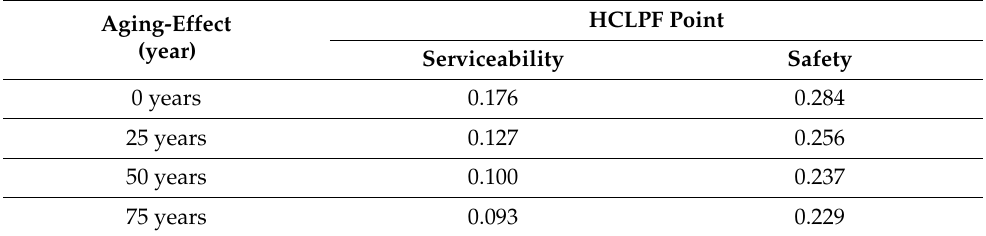
Figure 19. Reliability index curve for mean, median, 16% and 84% fractile curve; ( a ) 0 years, ( b ) 25 years, ( c ) 50 years, ( d ) 75 years. Table 3. High confidence of low probability of failure (HCLPF) point from the CGD response of each